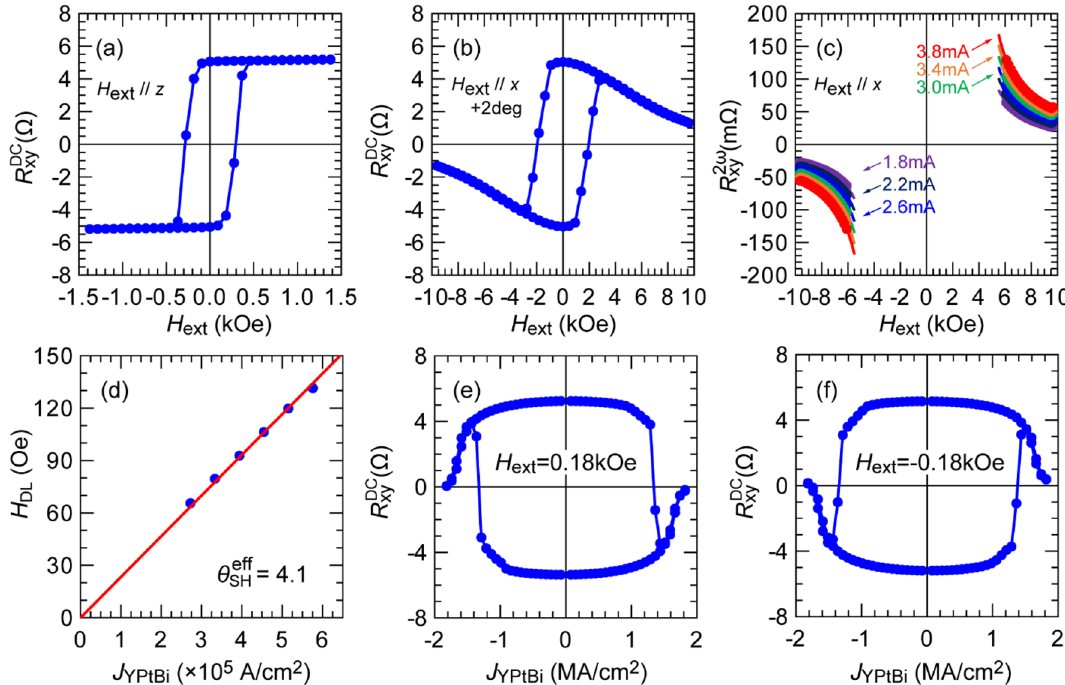
Figure 7. ( a , b ) DC anomalous Hall resistance in sample F ( σ YPtBi = 0.36 × 10 5 Ω −1 m −1 and t Co = 0.5 nm) measured with H ext applied along the z -direction and the x + 2°-direction, respectively. ( c ) Second harmonic Hall resistance of sample F measured with H ext applied along the x -direction and an AC current ranging from 1.8 to 3.8 mA, where dots are experimental data and solid curves show fitting results given by Eq. (2). ( d ) Antidamping-like field H DL as a function of the current density in the YPtBi layer. ( e , f ) SOT magnetization switching by DC currents with in-plane H ext of 0.18 and − 0.18 kOe applied along the x -direction,